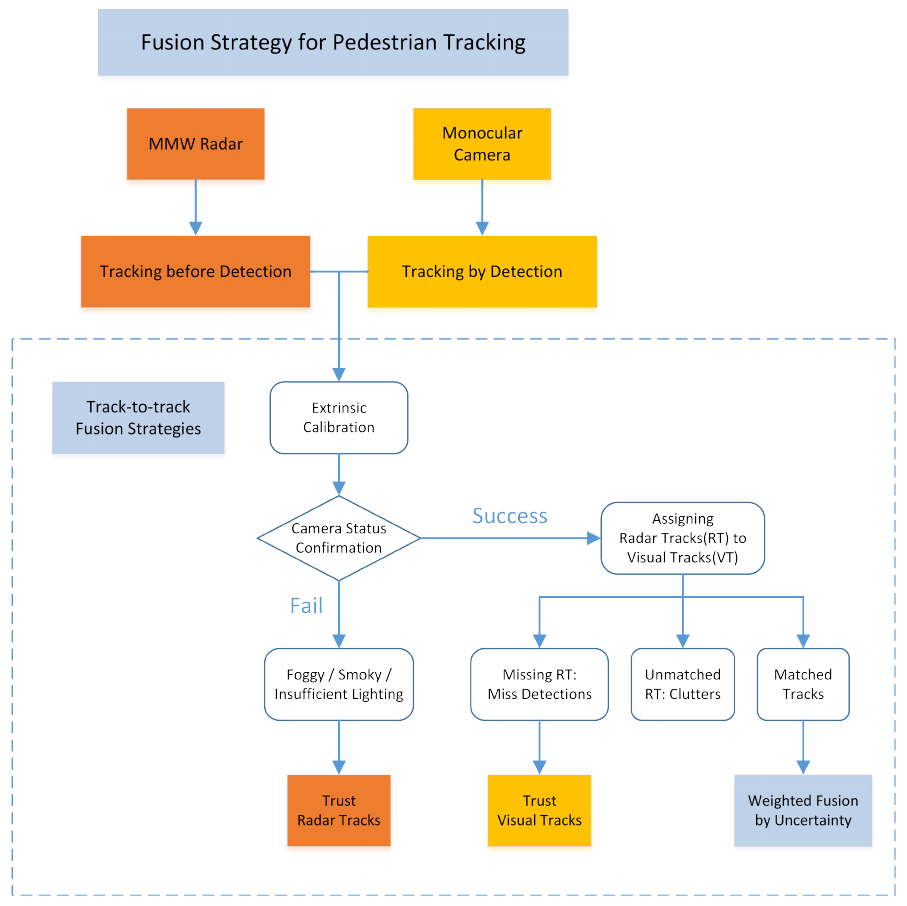
Figure 3. The proposed track-to-track fusion